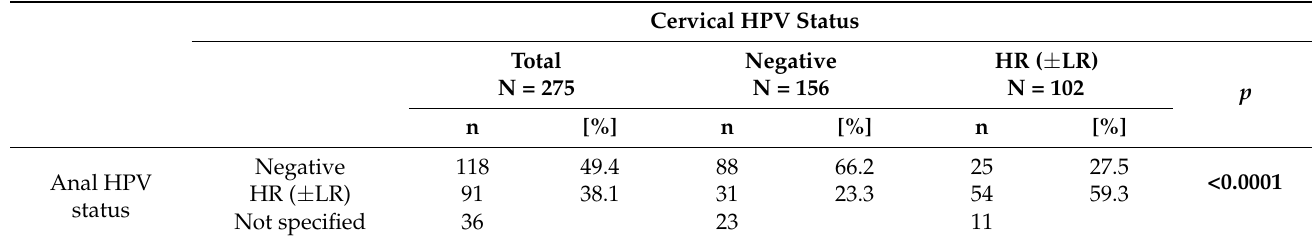
Table 3. Correlation between cervical and anal HPV